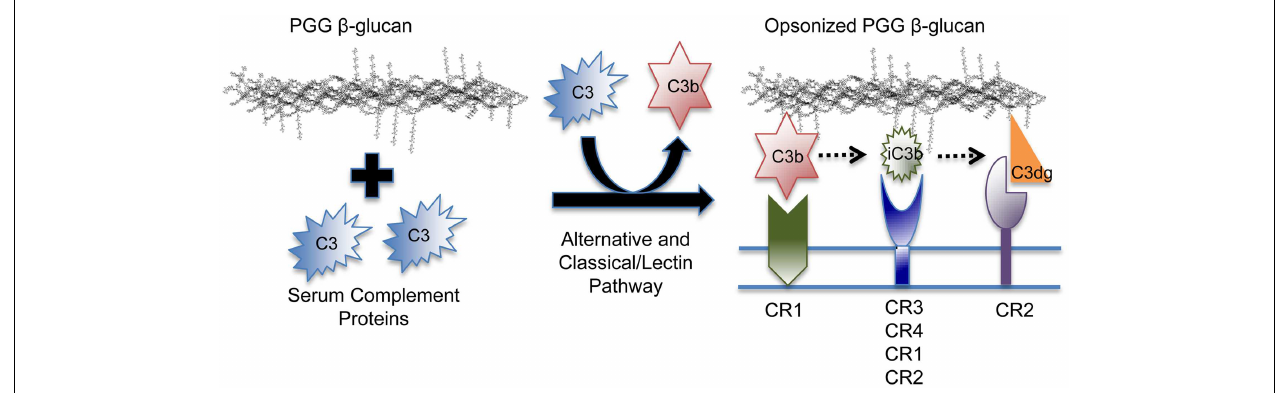
receptors, the opsonized PGG β -glucan has the potential to bind to CR1 via C3b, or CR3 via iC3b, or CR2 via C3dg.This study demonstrates that complement opsonization of soluble yeast β -glucan makes it amenable for recognition by several complement receptors on human innate and possibly, adaptive immune cells.